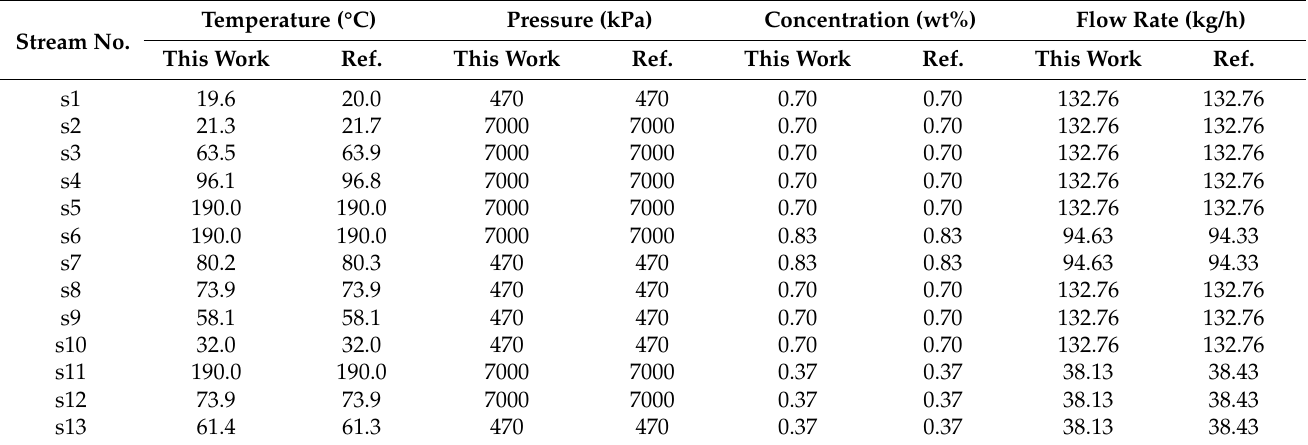
Table 2. Validation with published literature